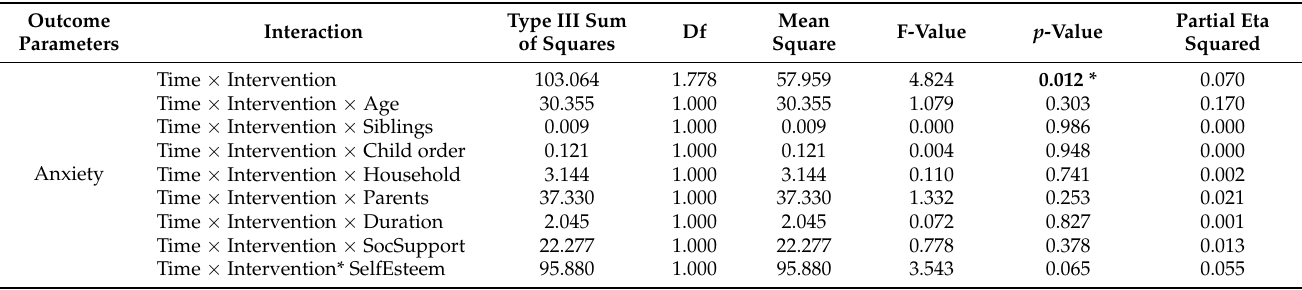
Table 7. A 3-way interaction between time, intervention and sociodemographic factors on anxiety and stress mental health status of